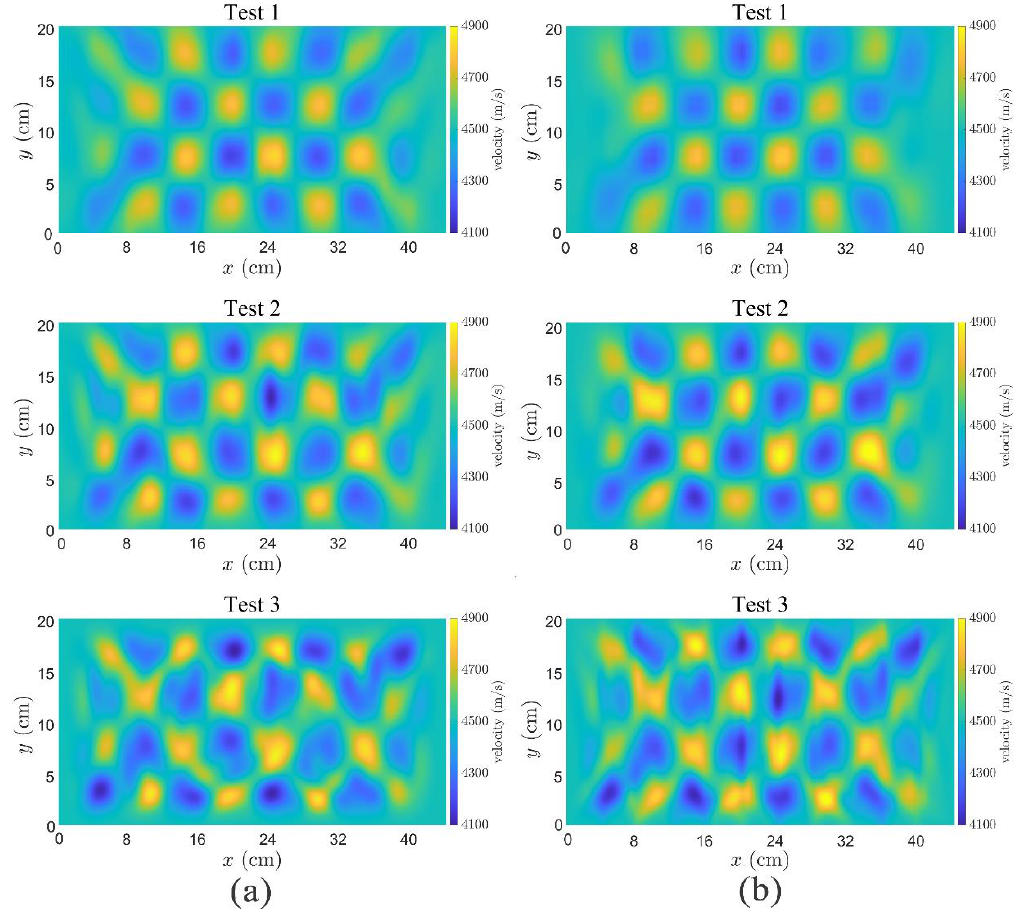
Figure 9. Synthetic checkerboard model for resolution tests.